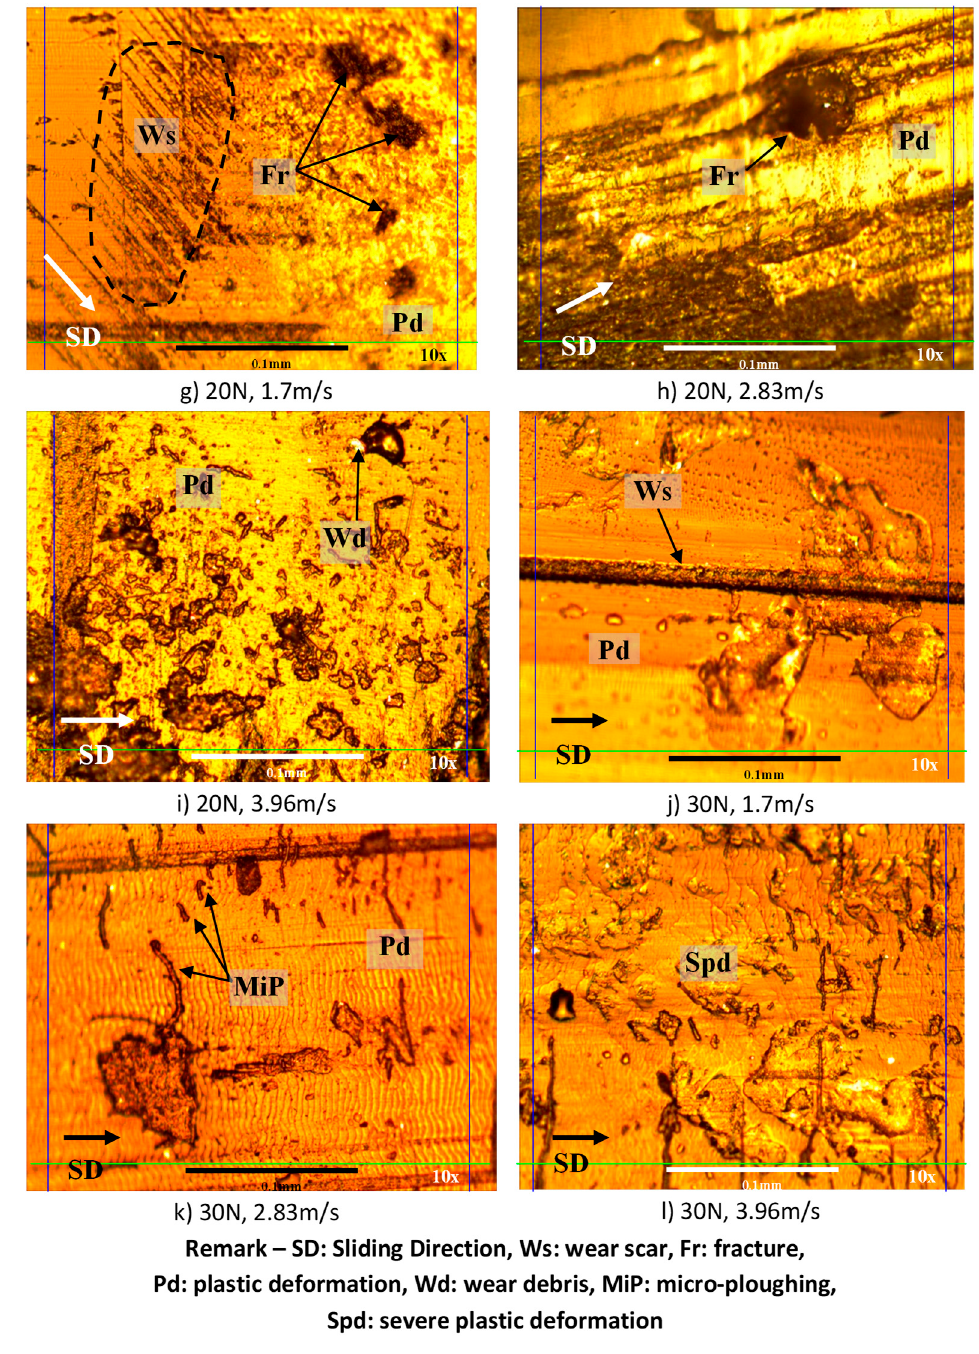
Figure 13. Photo micrographs of neat epoxy tested under different applied normal loads at different counterface sliding velocities .